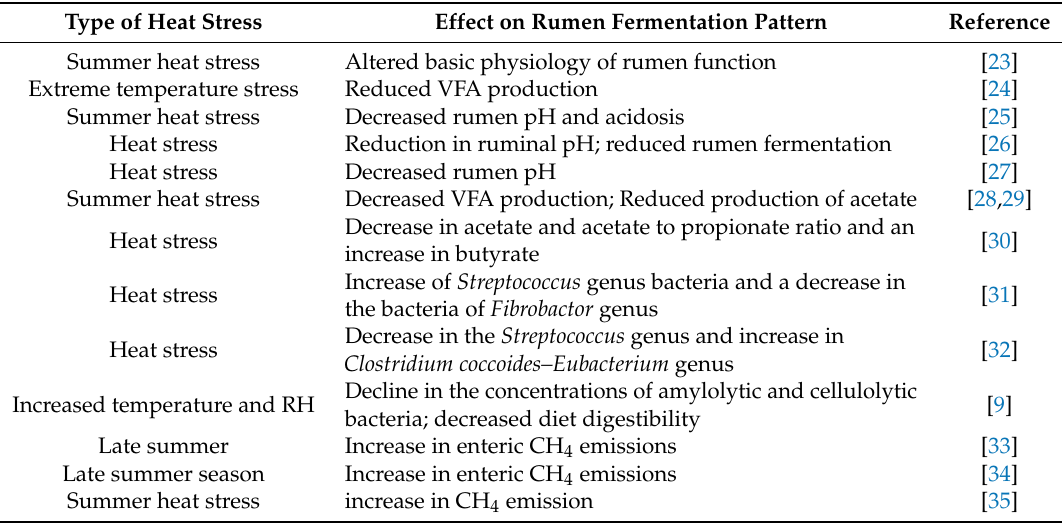
Table 2. Different impacts of heat stress on the rumen function in